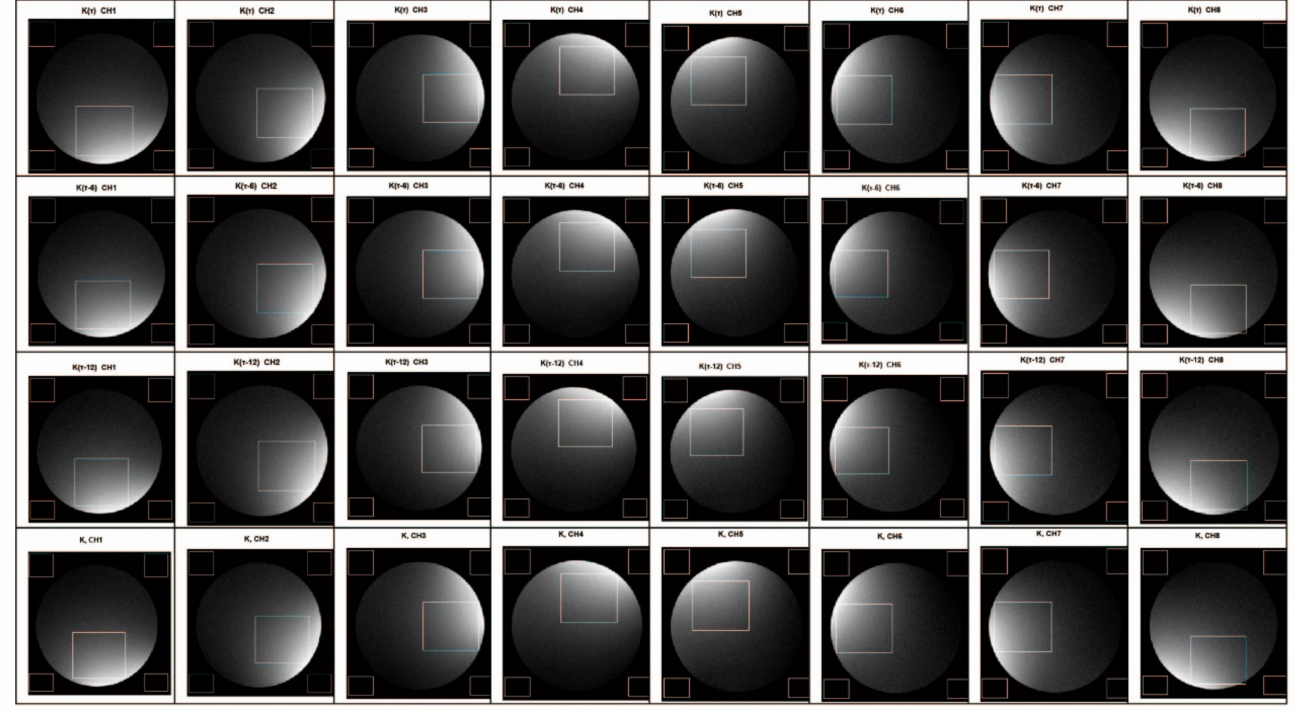
Figure 9. Eight-channel coil subchannel imaging